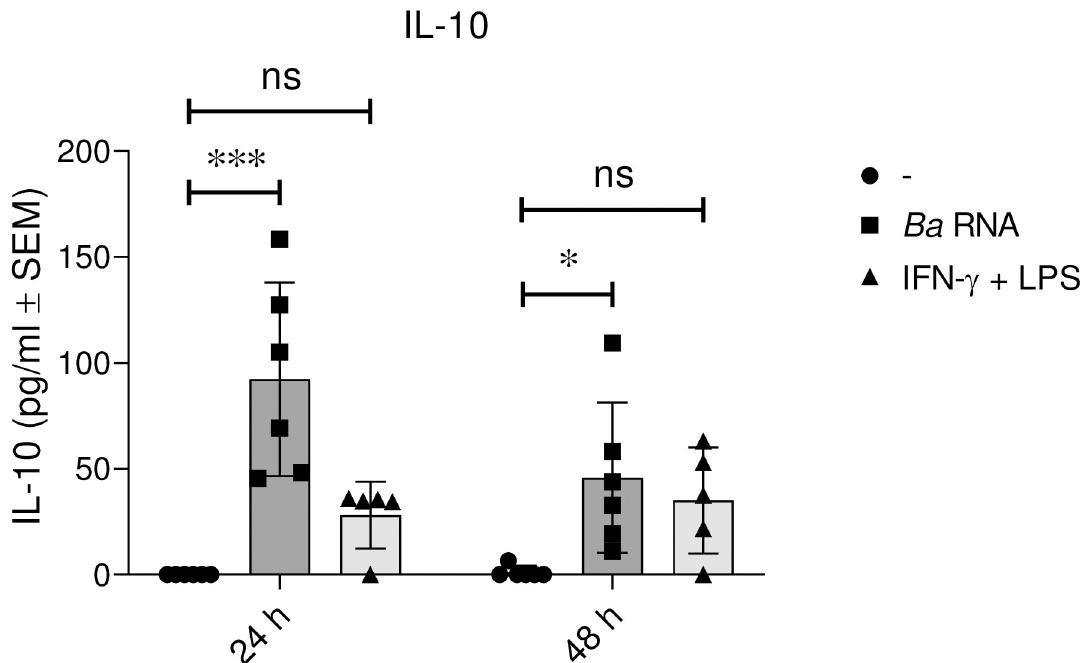
Fig 4. Ba RNA induces IL-10 secretion. Human M0 macrophages were stimulated with Ba RNA for 24 and 48 h. Secretion of IL-10 was quantified by ELISA sandwich in supernatants. Cells treated with IFN- γ and LPS were used as a positive control. Bars indicate the geometric means ± SEM of six independent experiments. ns, non-significant; � P < 0.05; ��� P < 0.001 vs. untreated cells (-).